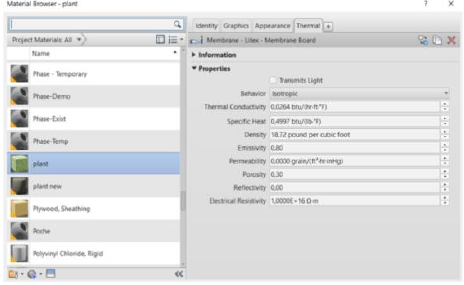
Figure 15 Living wall vegetation layer thermal values defined for the building with vertical green system in the Revit